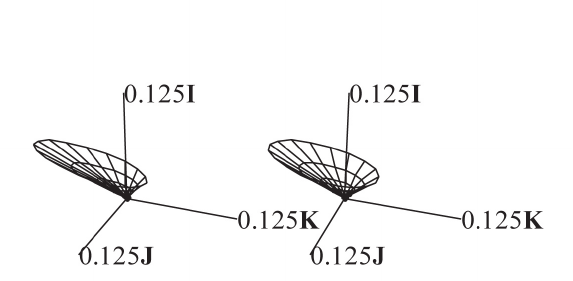
Figure 2 : The surface of tilted powers in symmet- ric dioptric power space for a thin lens of singular ( 1 0 ) or cylinder 0 1 x 90 in = D power F 0 1 , 0 conventional notation. The lens, a pure cylinder in air ( n* =1), has refractive index 1.5. The sur- face consists of curves of constant tilt angle ø and curves of constant tilt axis θ with the origin being the untilted power F . Intervals for tilt axes and for 0 tilt angles, and the axis length are all the same as for Figure